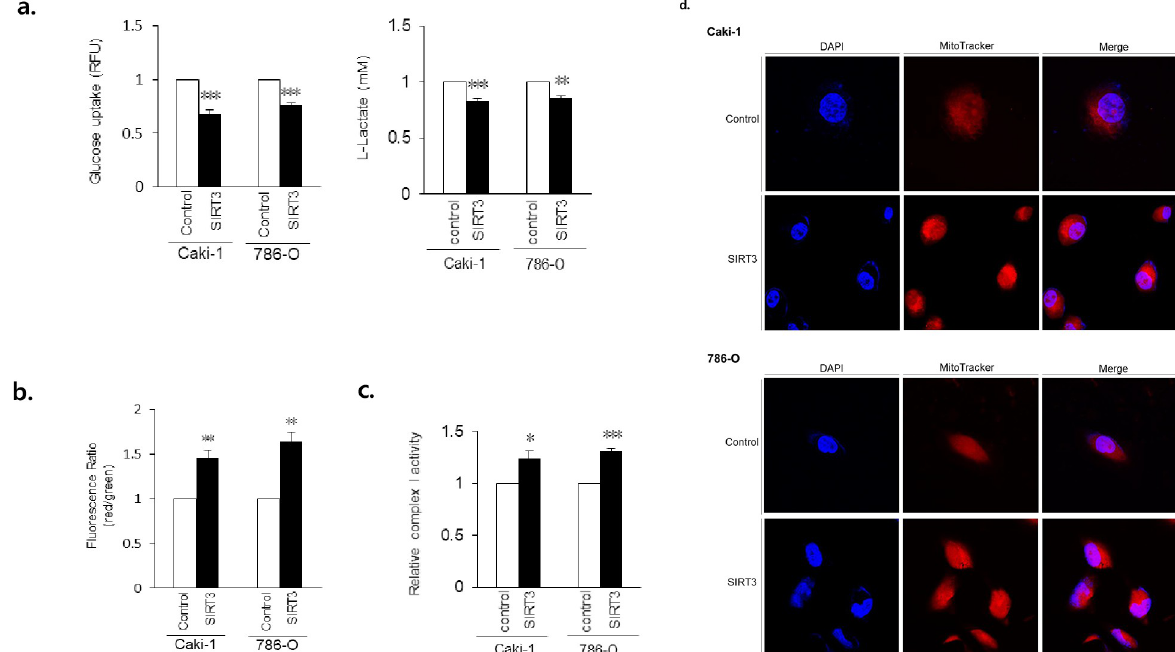
Fig 2. SIRT3 overexpression regulates mitochondrial function. a. Quantitative analysis of cellular glucose uptake (n = 6, per triplicate) and L- lactate production (n = 3, per triplicate). Values are expressed as mean ± SEMand control-cell values were set to 1. b. Mitochondrial membrane potentials were improved by SIRT3 overexpression. Data are expressed as mean ± SEM (n = 4, per triplicate) and control-cell values were set to 1. �� p < 0.01, ��� p < 0.001. c. Quantitative analysis of complex I enzyme activity assay. Values are expressed as mean ± SEM (n = 3, per triplicate) and control-cell values were set to 1. � p < 0.05. d. Representative confocal ccRCC images after SIRT3 overexpression (objective magnification 63 × ). Mitochondria were stained using MitoTracker Red CMSRos for 15 min prior to fixation and then subjected to DAPI